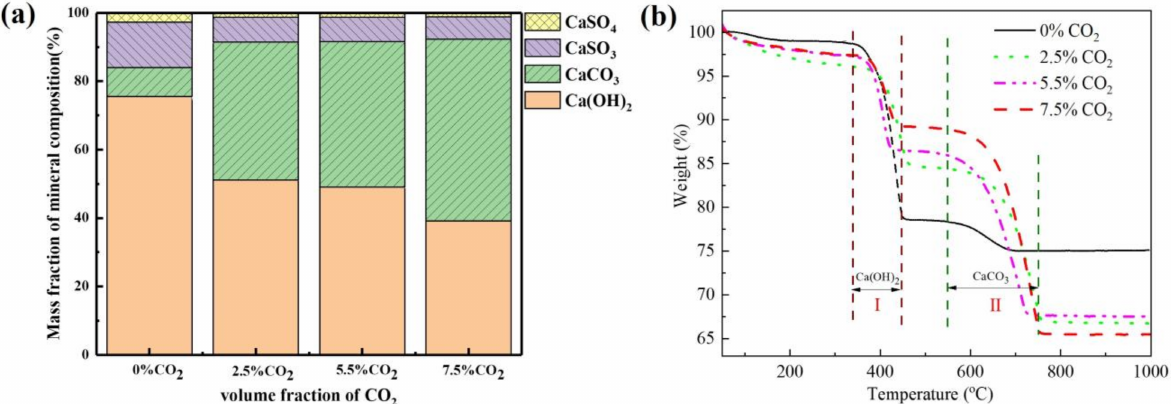
Figure 11. ( a ) Composition analysis; ( b ) TG curves of desulfurized ash under different CO 2 atmo- sphere6. The mechanism of CaCO 3 on the desulfurization